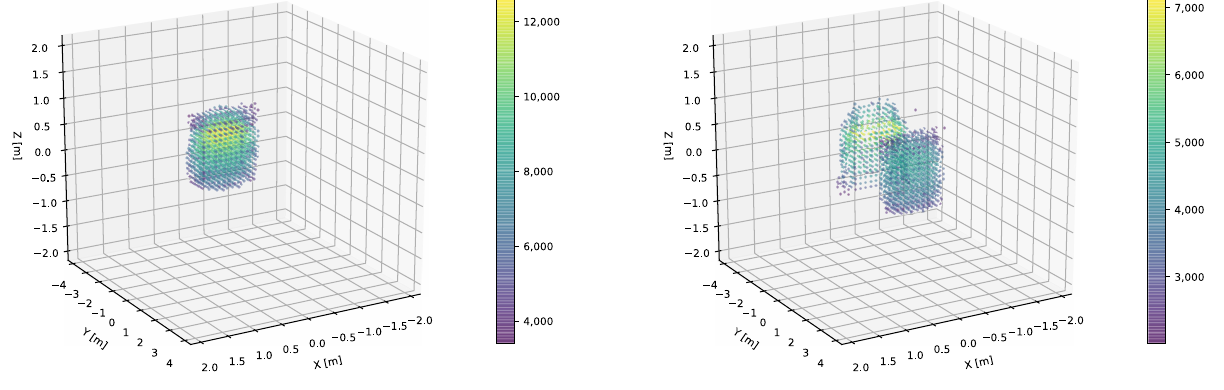
Figure 12. The 3D voxel map of separate water and lead blocks reconstructed with the parameter set optimized for lead as shown in Table 3 ( left ) and water as shown in Table 4 ( right ). The color of the voxel point represents the combined voxel score s comb